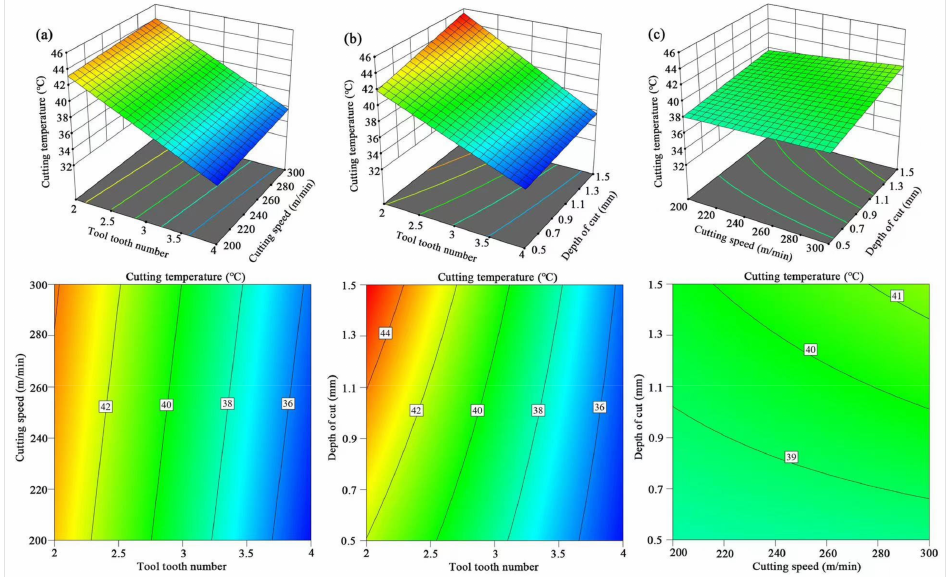
Figure 7. Three-dimensional surface and contour maps of cutting temperature ( a ) tool tooth number and cutting speed, ( b ) tool tooth number and depth of cut, and ( c ) cutting speed and depth of cut.